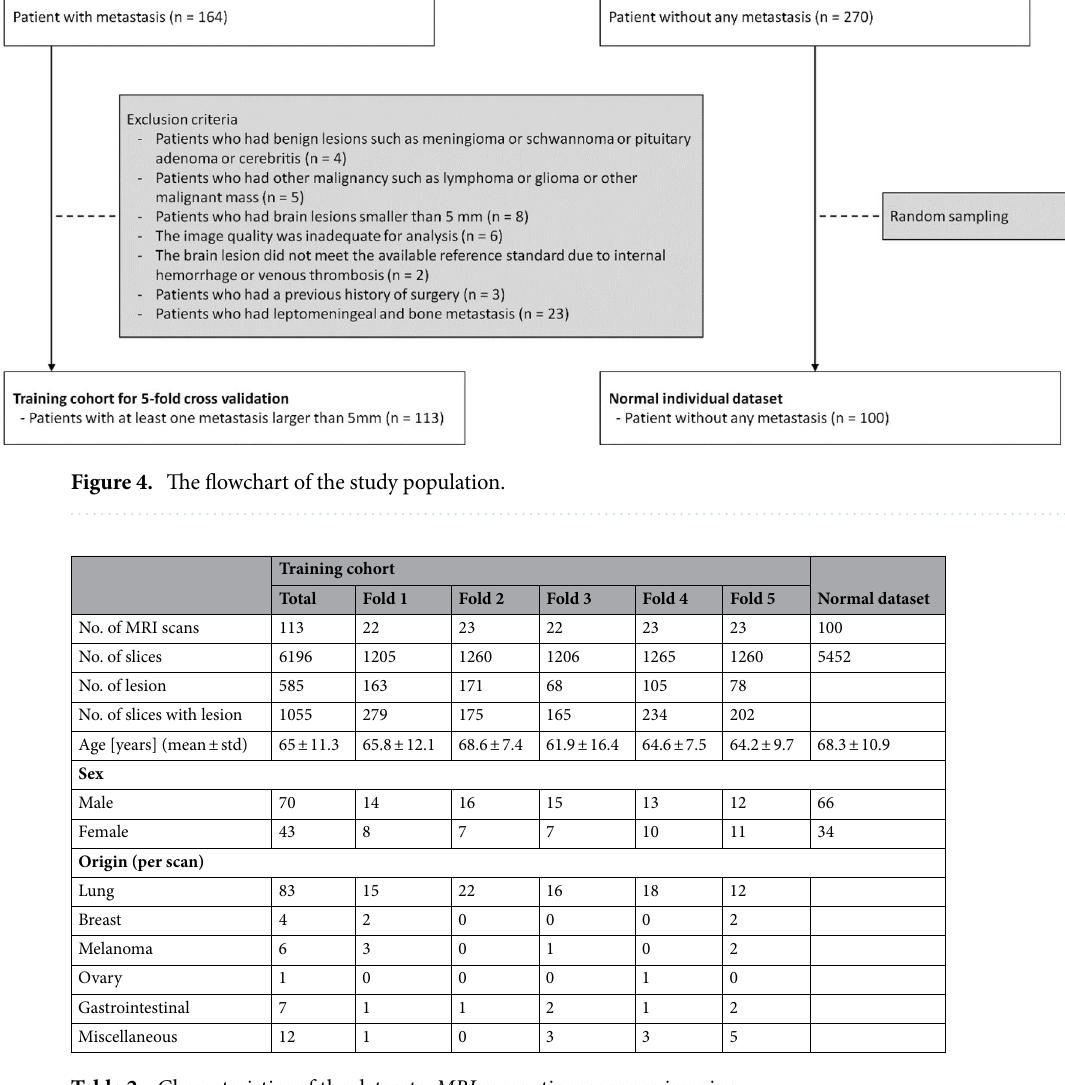
Table 2. Characteristics of the datasets. MRI magnetic resonance imaging.